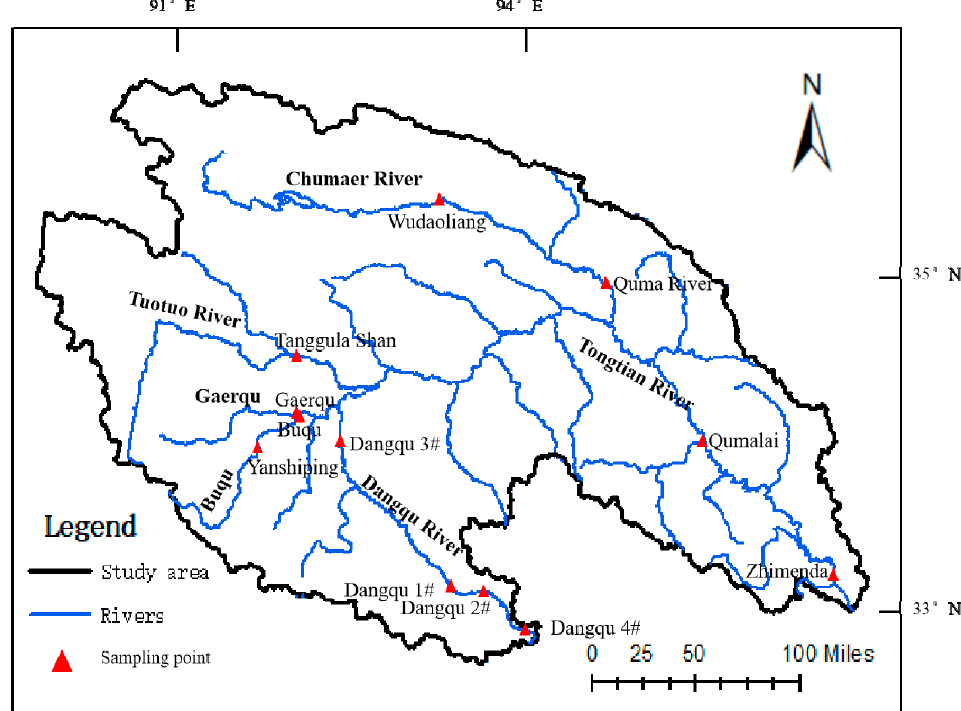
Figure 1. The schematic map in the study areas.